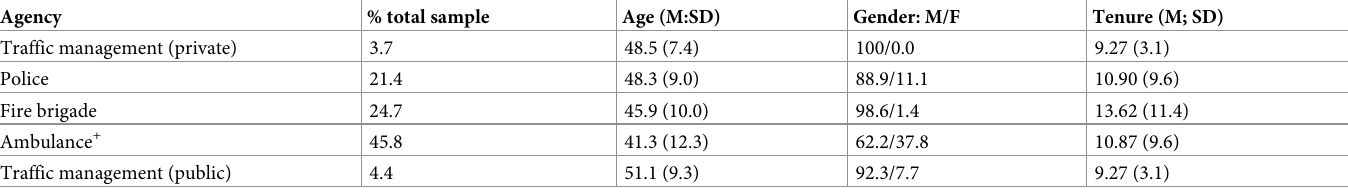
Table 1. Age, gender and tenure among the five agencies (N = 295).